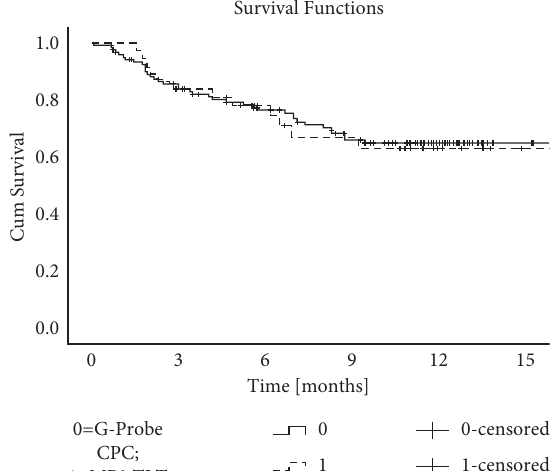
Figure 1: The Kaplan–Meier survival statistics (CPC � G-Probe cyclophotocoagulation, solid line; MP-TLT � MicroPulse laser treatment for glaucoma, dashed line) showed no difference between the success rates ( p �